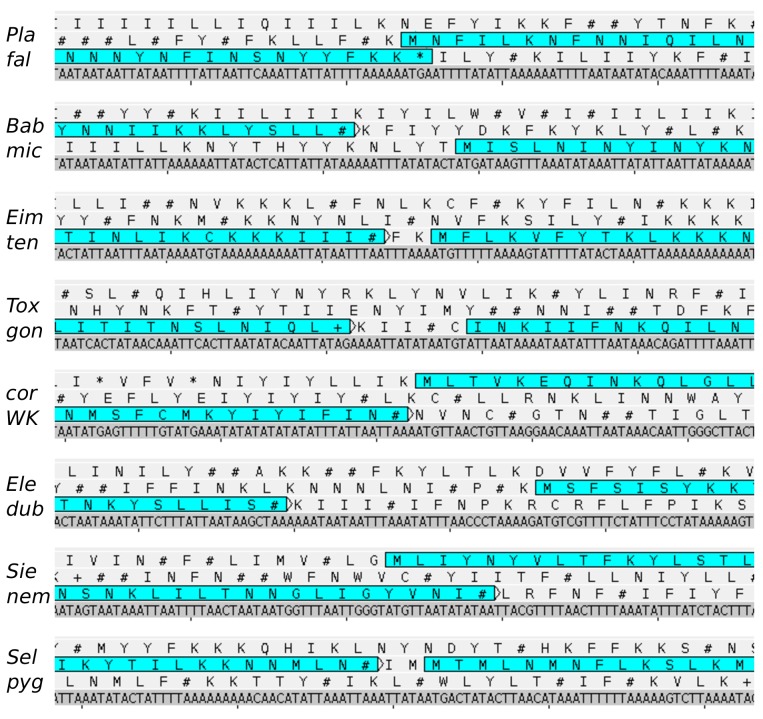
The region of the split in the apicomplexan plastid-encoded rpoC2.Plastid genome sequences and their three-frame amino acid translations are shown for representative apicomplexan species (snapshots from Artemis 17.0.1). Coding sequences are highlighted by horizontal rectangles. STOP codons are shown by # (=TAA), + (=TAG), and * (=TGA) symbols. In some taxa, TGA encodes for tryptophan (W). Note that the split occurs in a non-conserved part of rpoC2 so the corresponding region cannot be shown for a non-apicomplexan outgroup - rpoC2 genes in chrompodellids, Digyalum and all other plastids nevertheless lack the split.